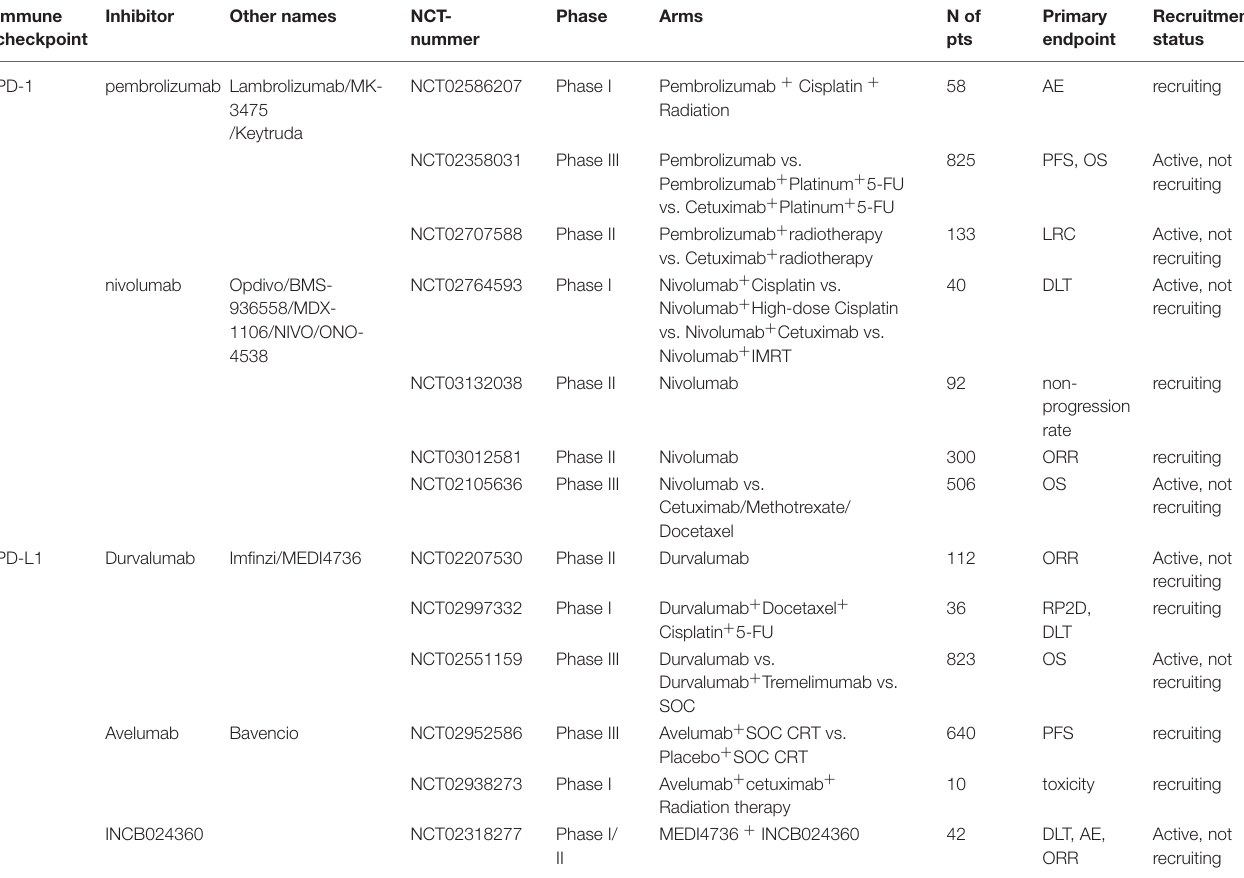
TABLE 2 | Clinical Trials on anti-PD-1/PD-L1 in head and neck cancers. Immune checkpoint